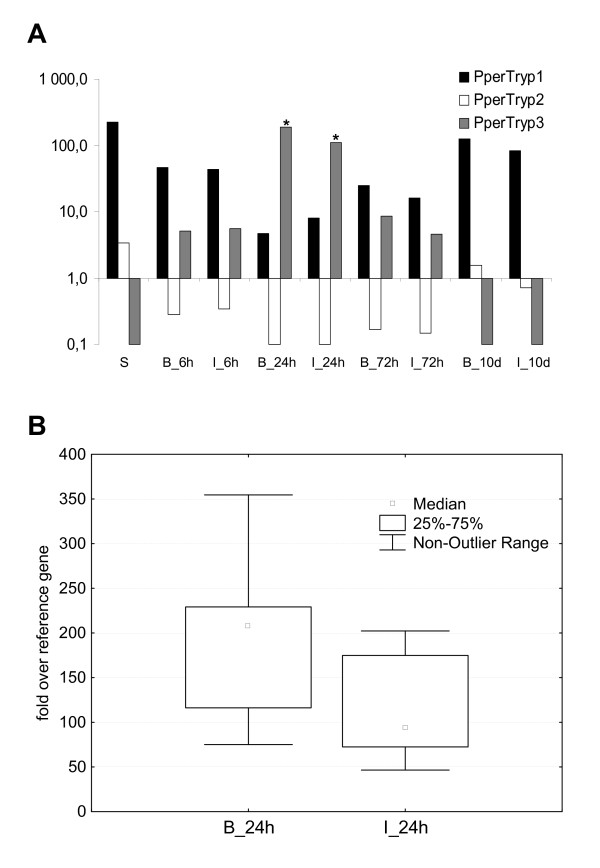
Influence of blood feeding and L. infantum infection on the dynamics of P. perniciosus trypsins expression. (A) The graph shows PperTryp1, PperTryp2 and PperTryp3 expression as fold over the reference housekeeping gene (PpPerS7 ribosomal protein) before and after the blood feeding (6 hours, 24 hours, 72 hours and 10 days). Each column represents the mean of ten females. S, sugar fed sand flies; B, blood fed sand flies; I, blood fed and L. infantum infected sand flies. The statistically significant difference between the infected and uninfected sand flies is indicated by (*). (B) The graph shows significant difference of PperTryp3 expression in uninfected (B_24) and infected (I_24) sand flies 24 hours after blood feeding; Mann-Whitney U Test (U = 20; Z = 2.268), p = 0.023.